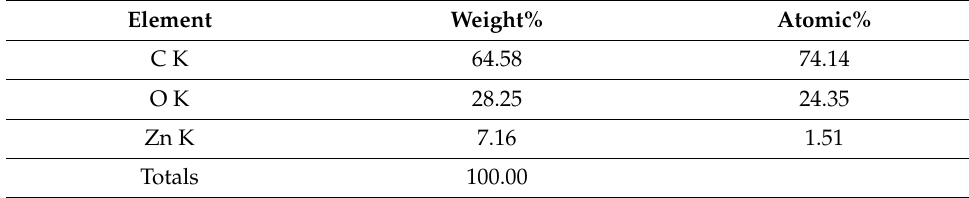
Figure 4. EDAX analysis of M. indica seed extract synthesized ZnO NPs. Table 1. Elements present in the nanoparticles.